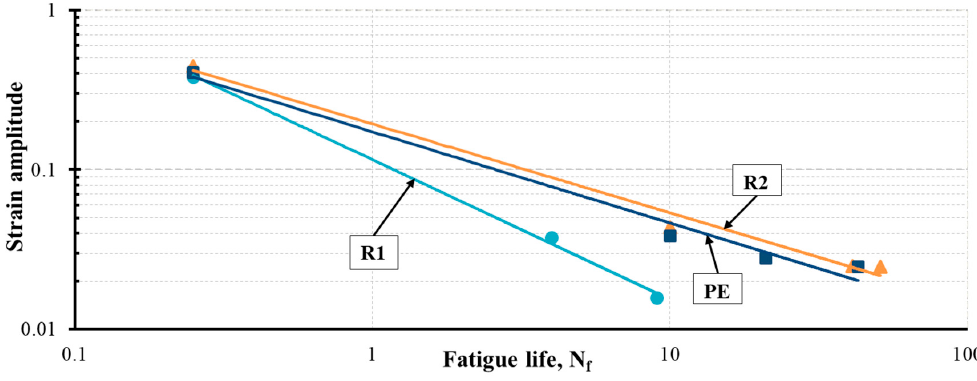
Figure 7. Curves for different stress states specimens under ELCF.